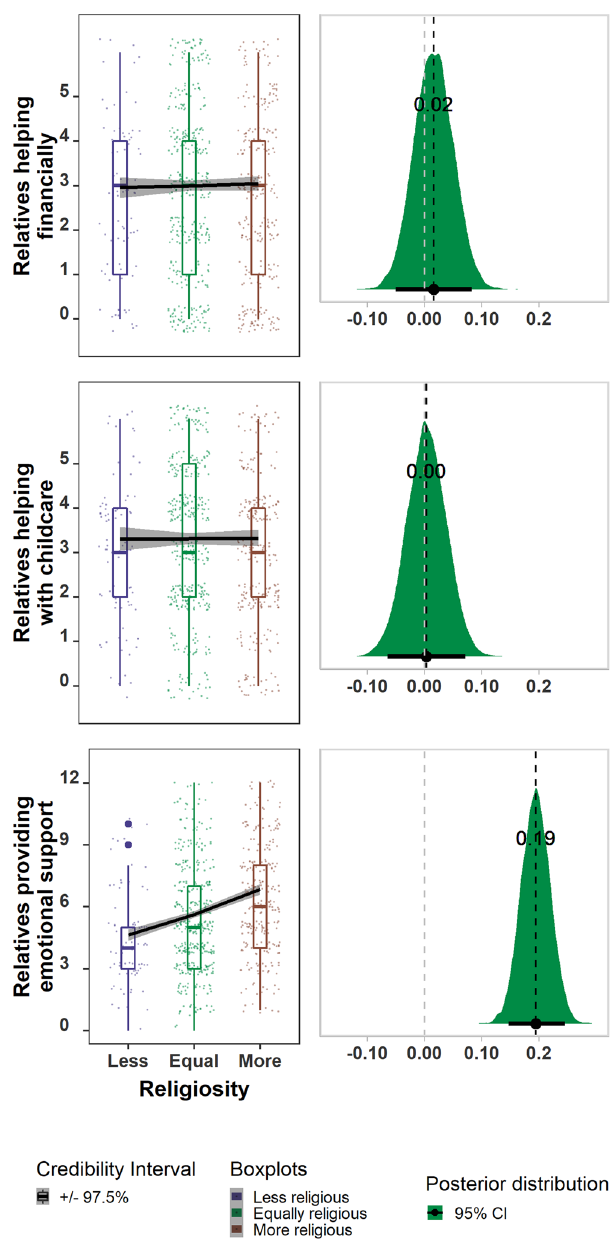
Figure 3. The number of relatives providing different types of help . More religious women do not receive additional financial support (top row) or childcare (middle row) from relatives but are more likely to receive emotional support from relatives (bottom row). Raw data points and error bars represent 97.5 percent credibility intervals for each category of increasing religiosity (left side) and the density interval for the respective posterior distributions and mean parameter estimates for religiosity for each model